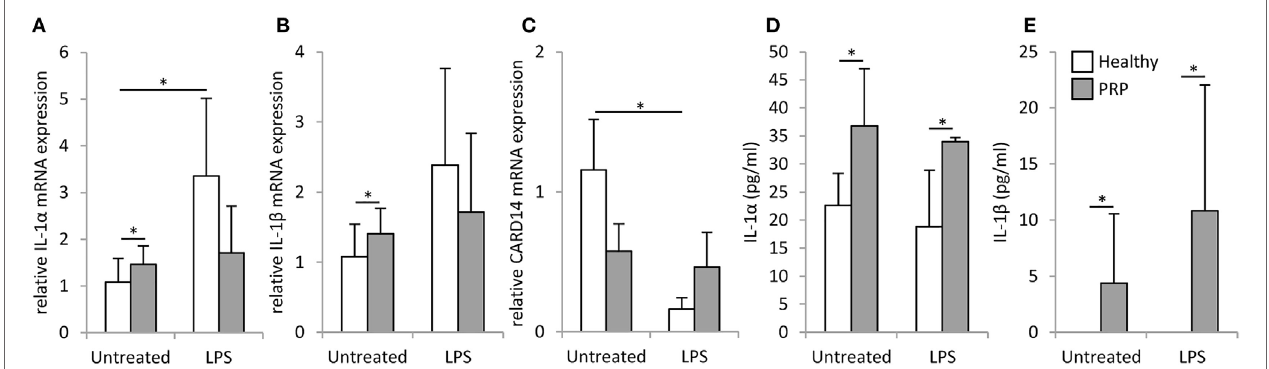
FIgURe 3 | mRNA expression and secretion of inflammatory cytokines in keratinocytes. The mRNA expression of IL­1 α (a) and IL­1 β (B) and CARD14 (C) measured by RT­PCR and secretion of IL­1 α (D) IL­1 β (e) measured by ELISA were detected in keratinocytes derived from a healthy individual (white bars) and the Pityriasis rubra pilaris (gray bars) patient 6 h after treatment with 500 ng/ml LPS, time matched, and untreated samples served as controls. mRNA expression was normalized to the 18S rRNA expression and compared to the expression level of the untreated healthy control samples. Data are represented as mean ± SE of three experiments; * p <